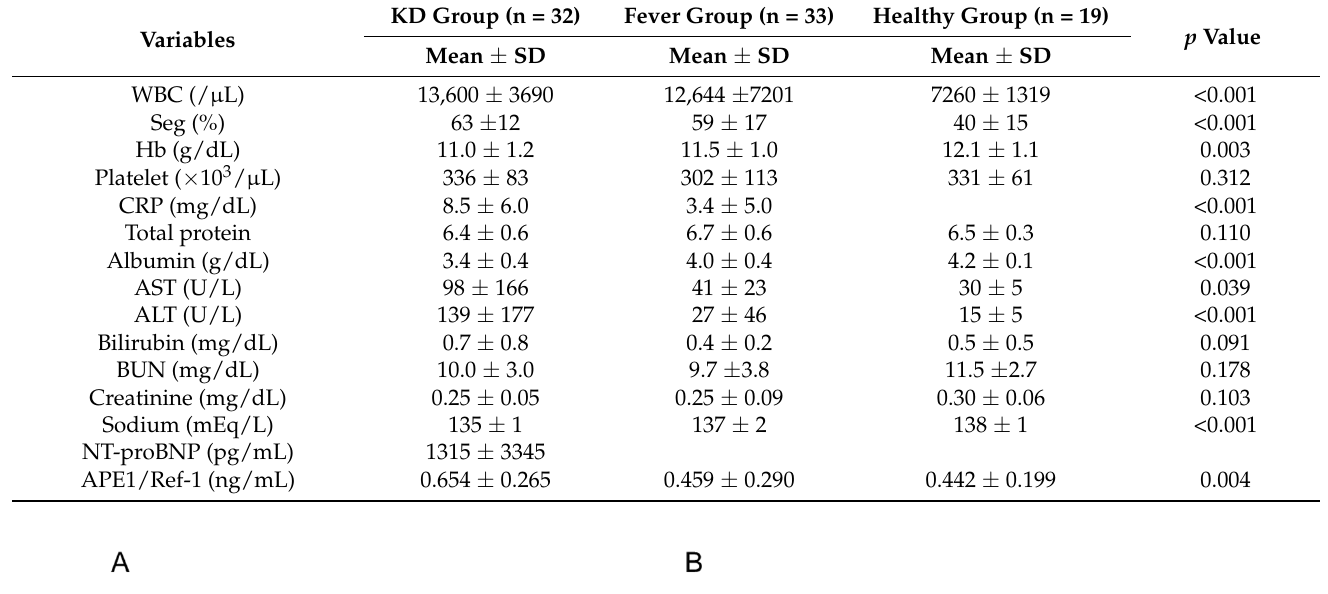
Table 2. Laboratory data.